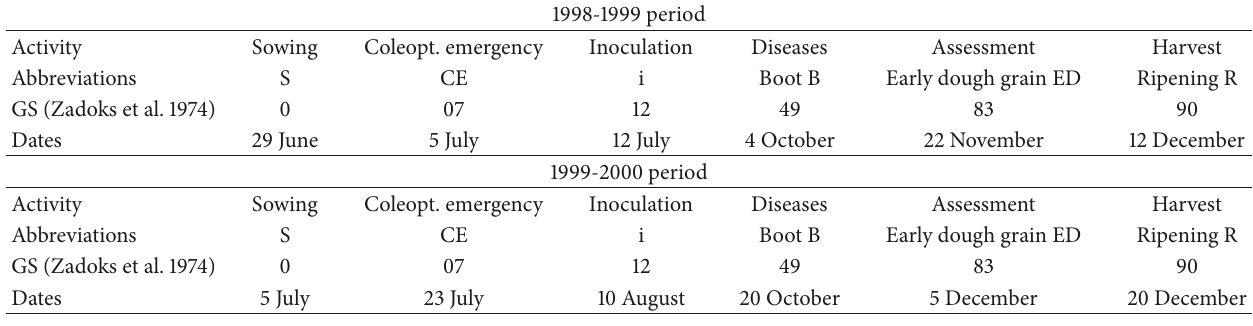
Table 1: An overview of the main dates of the experimental works for 1998-1999 and 1999-2000 periods.